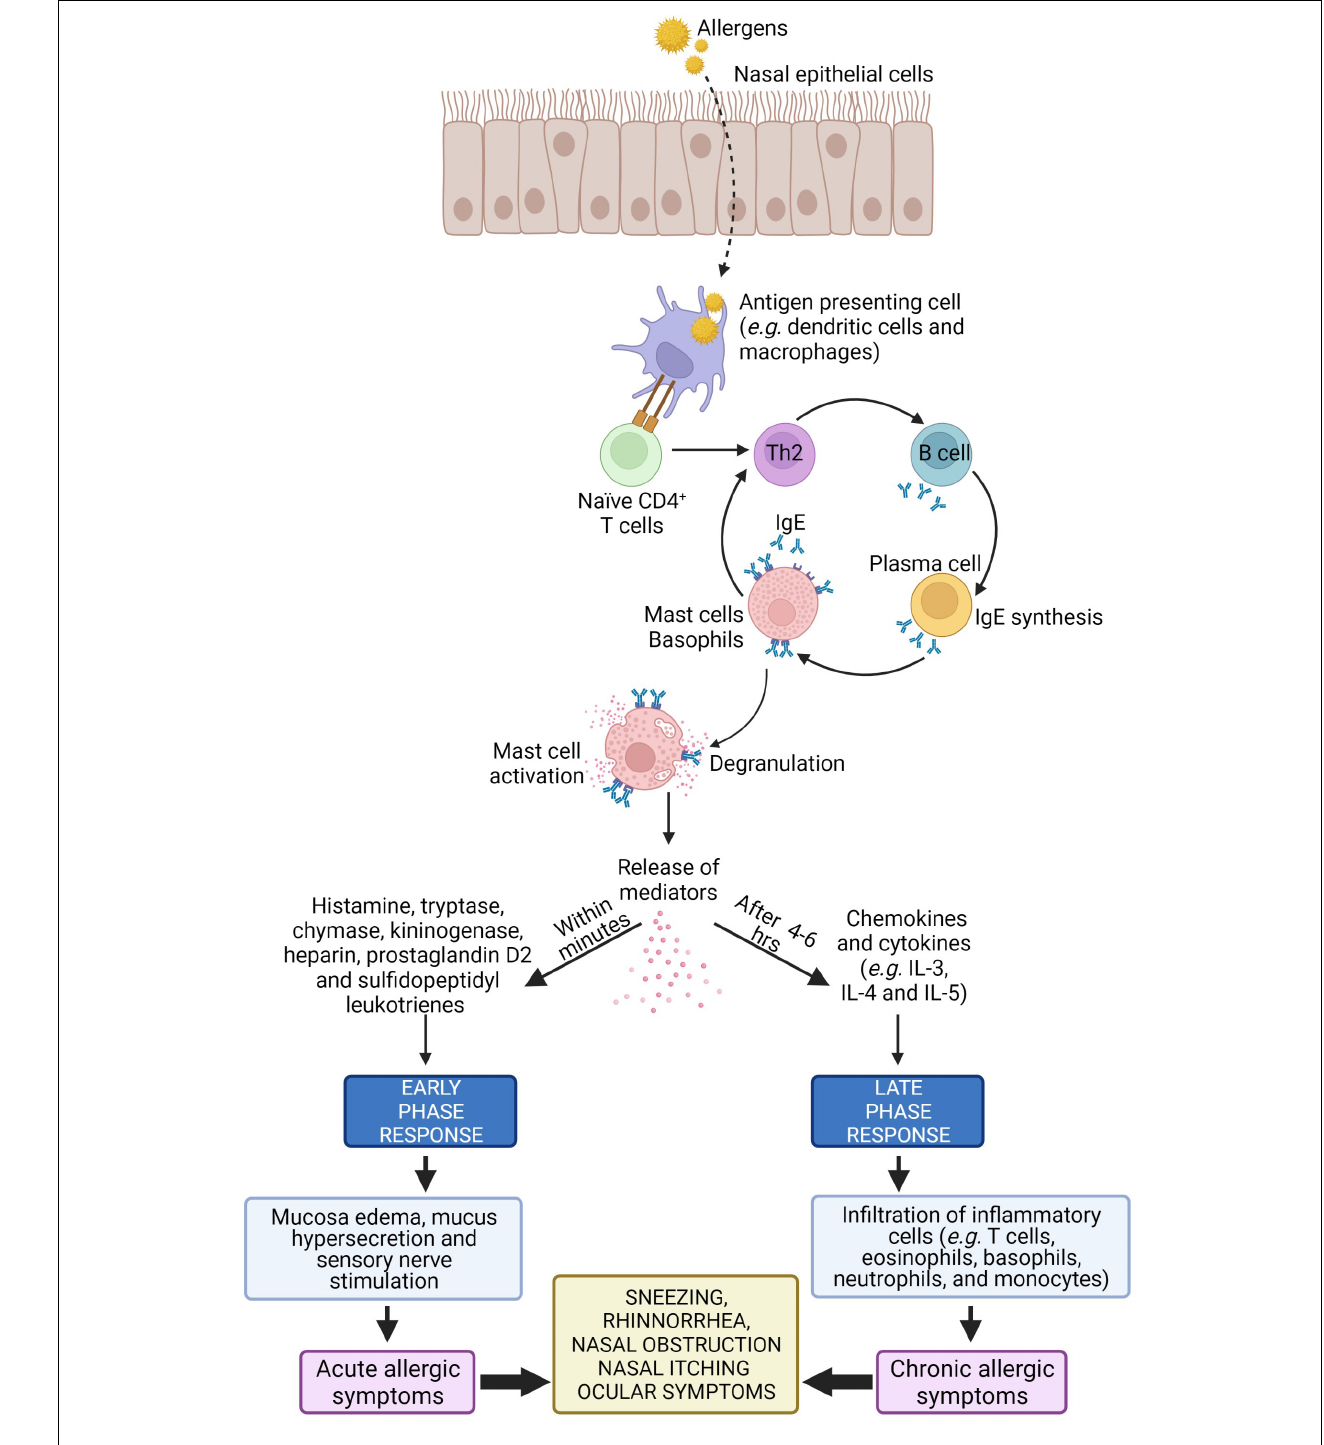
FIGURE 2 | Schematic presentation of pathophysiology of AR (12, 59, 64, 66). See texts for details.